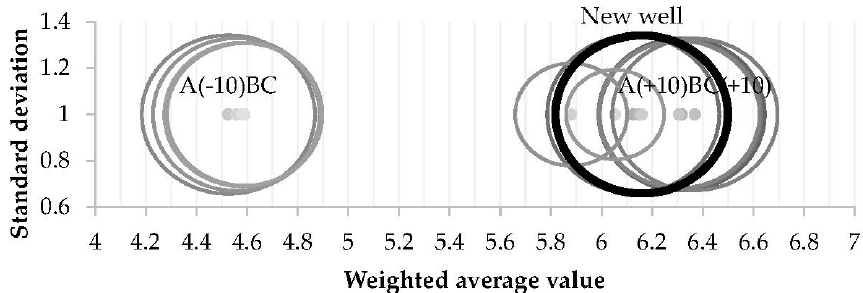
Figure 8. Model sensitivity −10% and +10% change.